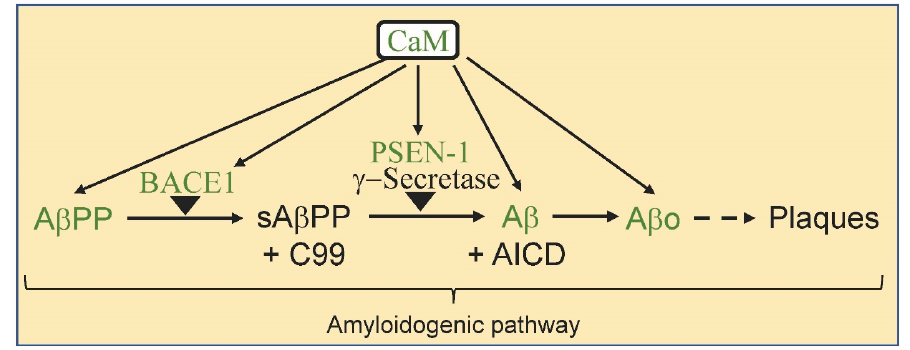
Figure 3. Calmodulin involvement in early events of amyloidogenic pathway. A β , amyloid beta; A β o, amyloid beta oligomers; A β PP, amyloid- β precursor protein; sA β PP, amyloid- β precursor protein; AICD, APP intracellular domain; BACE1, beta-secretase 1; C99, 99-residue C-terminal fragment; CaM, calmodulin; PSEN-1, Presenilin-1.